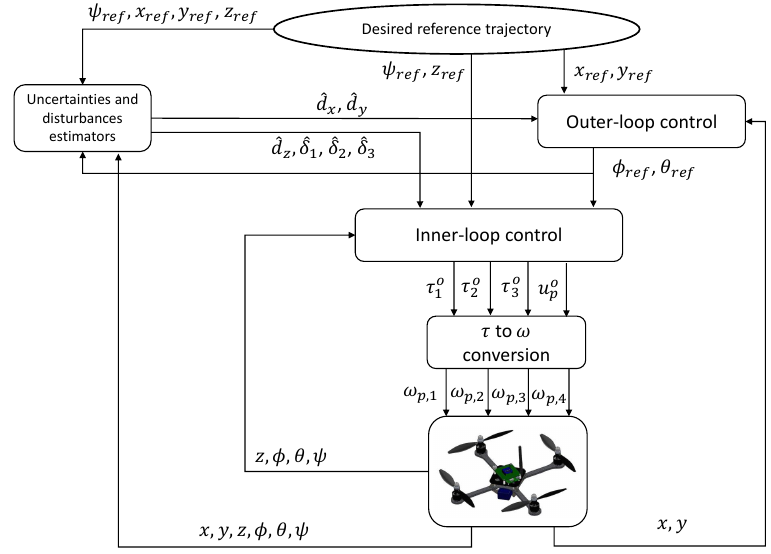
Figure 2. Functional block diagram of the